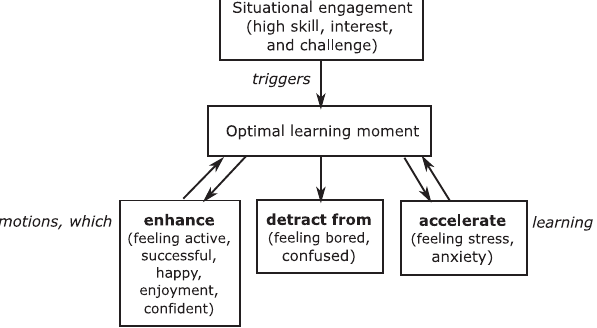
FIG. 1. Relationships between situational engagement, optimal learning moment, and other situational emotions according to the framework of optimal learning moment. Figure adapted after Schneider et al. [22] (Fig.